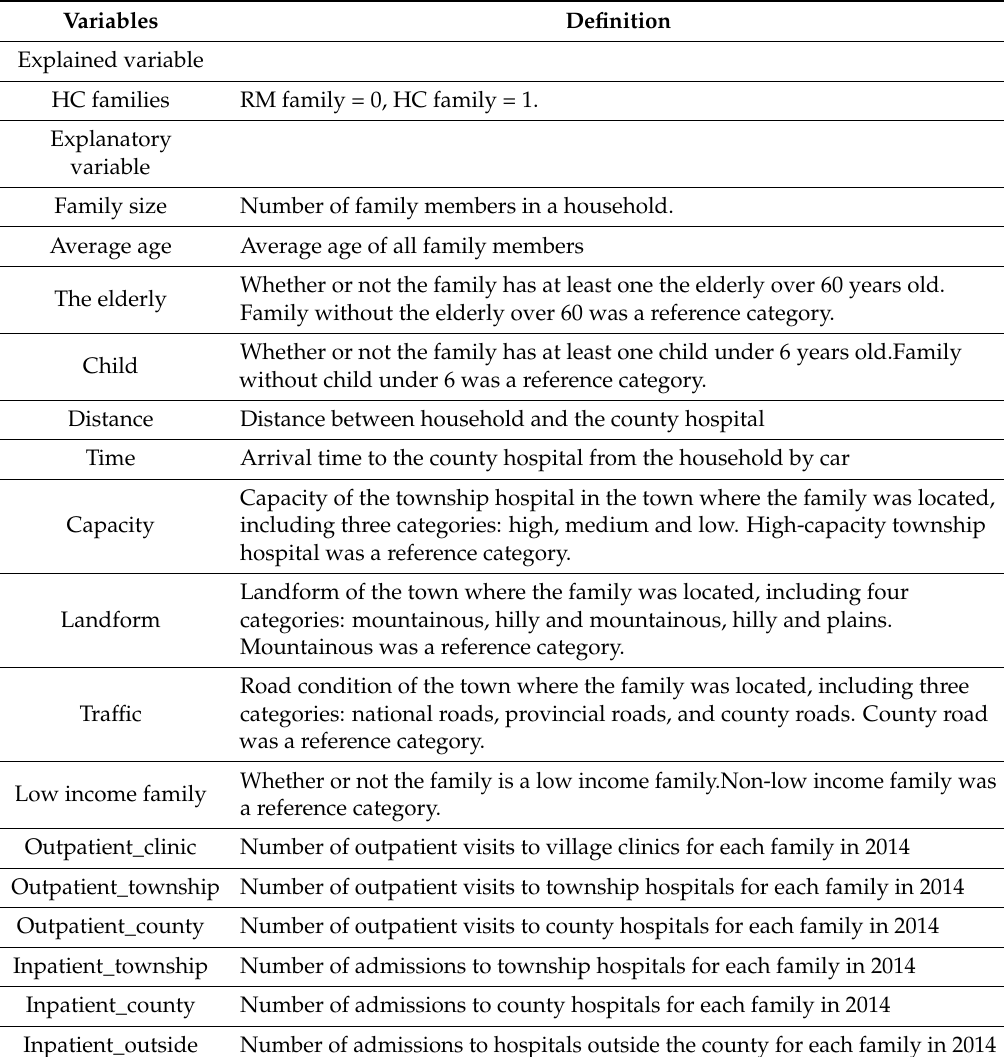
Table A1. Variables list of logistic regression